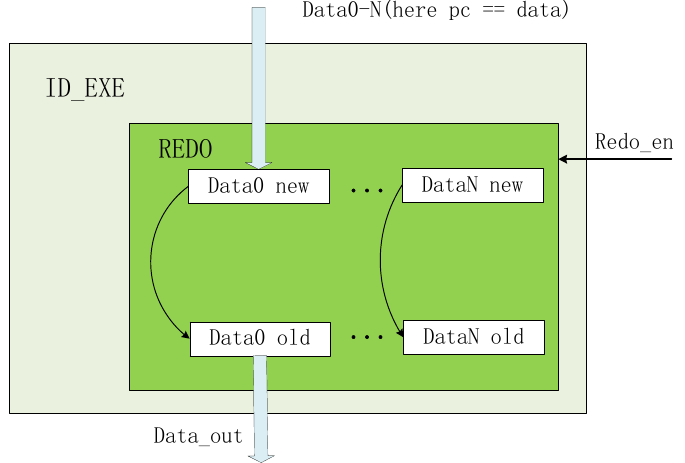
Figure 8. REDO module: It is embedded in the timing logic module to store temporary data in real-time. When the REDO operation is performed, it realizes the function of data replacement.